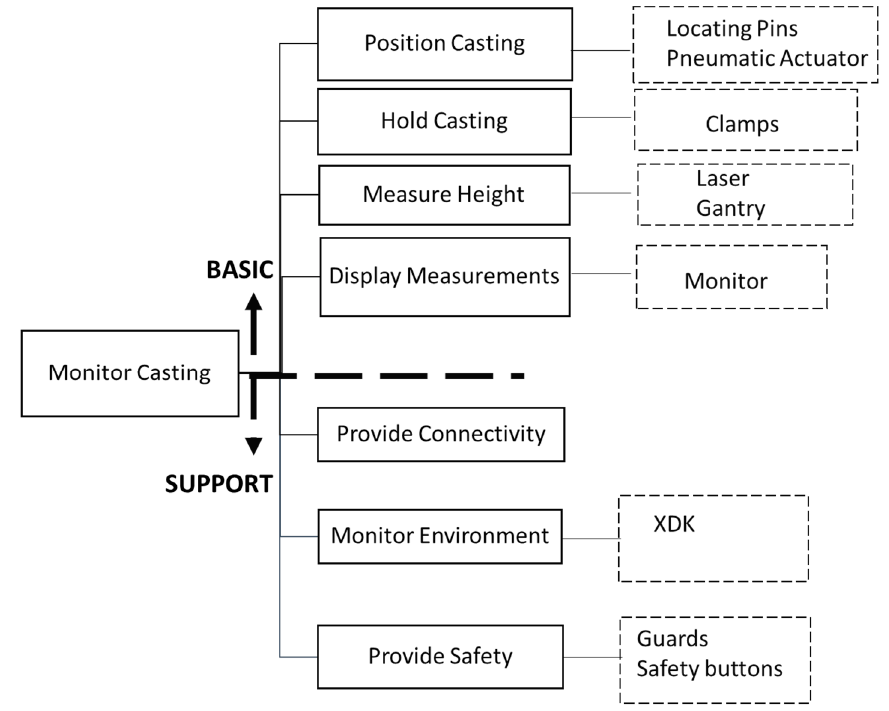
Figure 9. The functional tree for the proposed design. Connectivity and monitoring of the environment are support functions that help improve intelligence of the machine.